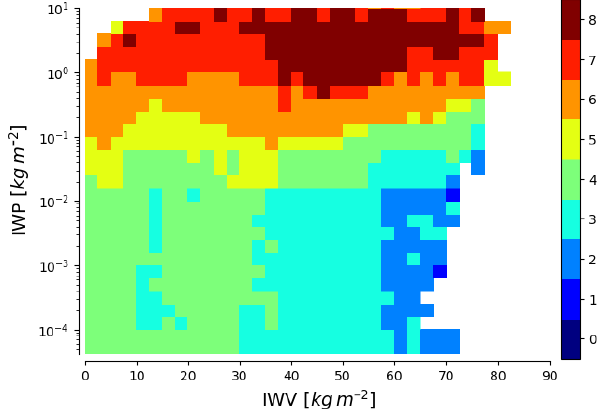
Figure 8. Estimated degrees of freedom (DoFs) of ICI observations, as a function of integrated water vapour (IWV) and IWP. Based on the tropical part of the retrieval database (Sect.